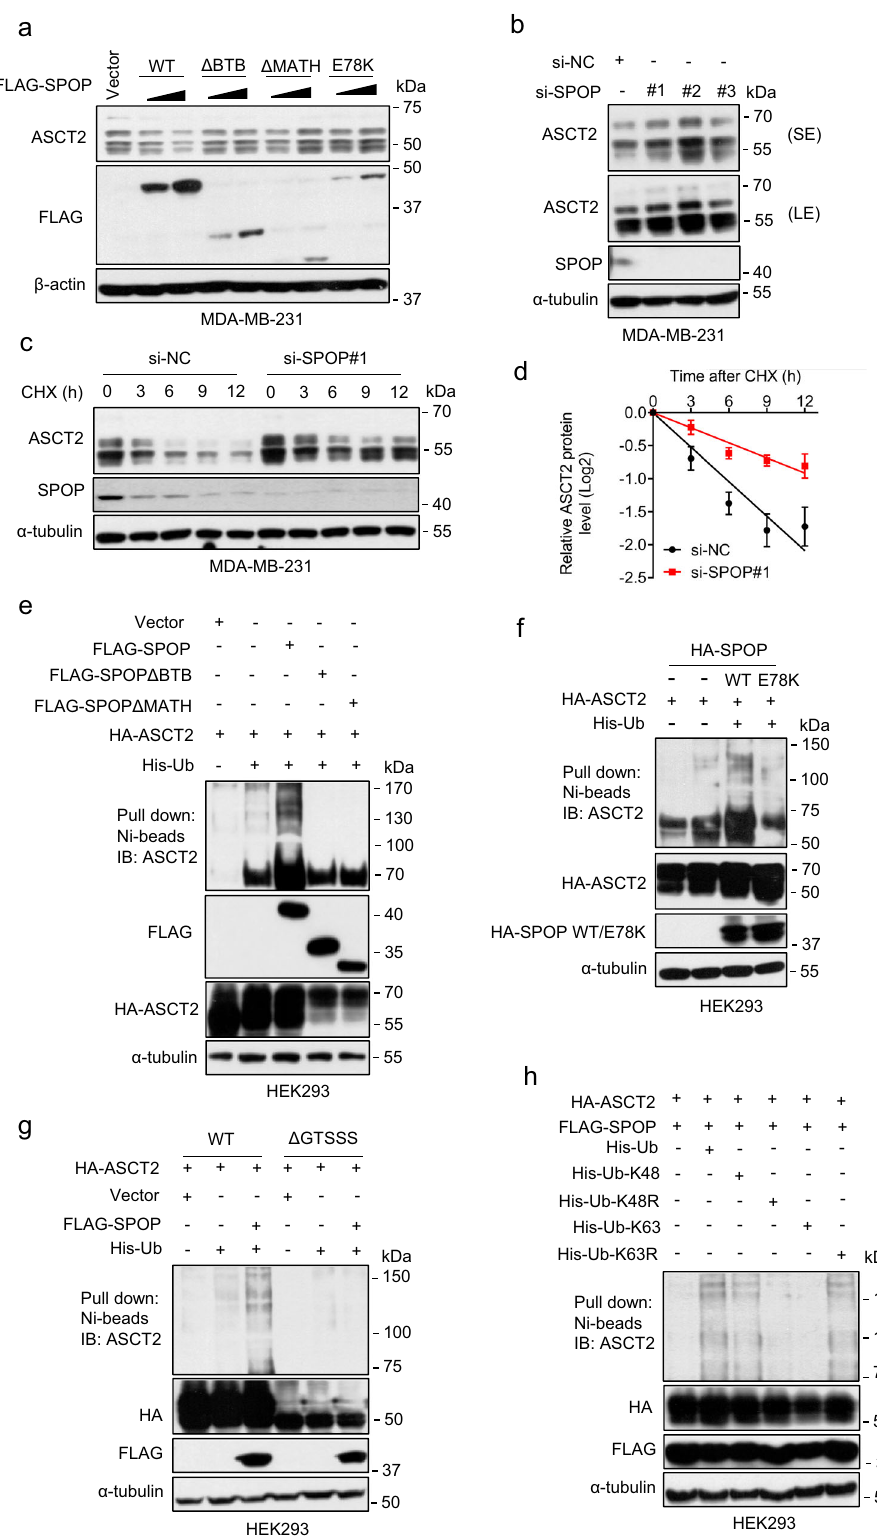
Fig. 3 SPOP shortens ASCT2 protein half-life and promotes ASCT2 ubiquitylation. a MDA-MB-231 cells were transfected with FLAG-SPOP and various mutants for 48 h, followed by immunoblotting. b MDA-MB-231 cells were transfected siRNAs targeting SPOP for 48 h, followed by immunoblotting. c , d MDA-MB-231 cells were transfected with siRNA targeting SPOP (si-SPOP#1) or scramble control siRNA for 48 h, then incubated with cycloheximide (CHX). Cells were harvested at indicated time points for immunoblotting ( c ). The band density of ASCT2 was quanti fi ed using ImageJ software and normalized to α -tubulin (mean ± SD, n = 3) ( d ). e – h HEK293 cells were transfected with indicated SPOP plasmids ( e ), indicated ASCT2 plasmids ( f ), or with indicated ubiquitin mutants ( h ) lysed under denaturing conditions, followed by Ni-beads pulldown, and immunoblotting for ASCT2 (top panels). The bottom panels are direct immunoblotting using whole cell extracts. Source data are provided as a Source Data fi